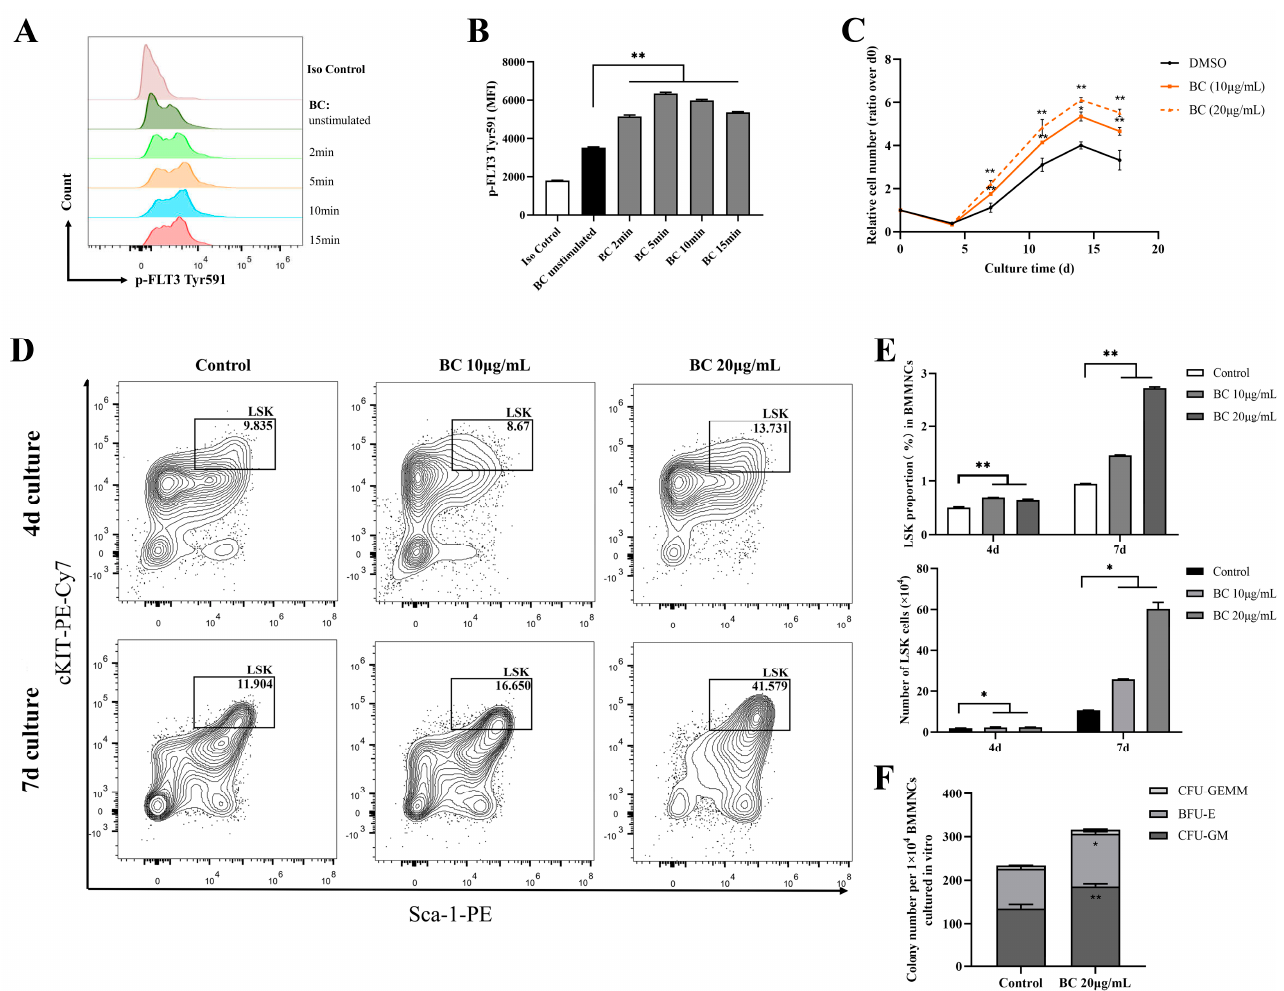
Figure 3. BC promotes the proliferation of mouse BMMNCs and the expansion of their HSPC population in vitro . ( A , B ) Flow cytometry analysis of FLT3 phosphorylation in mouse BMMNCs cultured in vitro with or without BC (10 μ g/mL) treatment for 5 − 15 min. ( A ) Flow cytometry histogram showing the intensity of p − FLT3 Tyr591 versus cell counts. ( B ) The mean fluorescence intensity (MFI) of p − FLT3 Tyr591 from three independent experiments. ( C ) Cell counting of mouse BMMNCs cultured in vitro with or without BC treatment at different timepoints, which was presented as relative cell number to the cell number at day 0. Data represent three independent experiments. ( D ) Representative flow cytometry profiles to show the percentages of LSK (Lineage - Sca-1 + cKIT + ) in mouse BMMNCs cultured in vitro with or without BC treatment for 4 days or 7 days. Gates shown identify the LSK populations from Lineage - (Lineage negative cells) population. ( E ) The proportion and absolute number of LSK population in ( D ). Data represent three independent experiments. ( F ) Colony counting of HSPCs derived CFUs from 1 × 10 4 BMMNCs cultured in vitro with or without BC treatment for 4 days. CFU − GM: colony-forming unit of granulocyte and macrophage; BFU-E: burst − forming unit − erythroid; CFU − GEMM: colony − forming unit of granulocyte, erythrocyte, monocyte and megakaryocyte. Data represent triplicate experiments. All data are shown as mean ± SEM, * p < 0.05, ** p < 0.01 (Student’s t test).